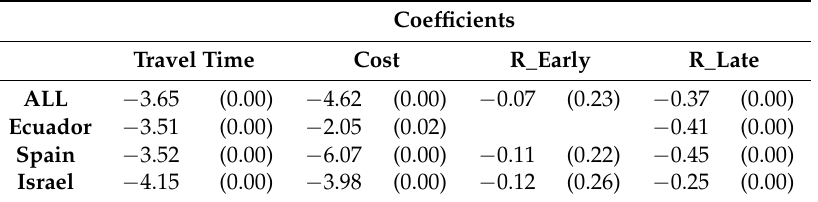
Table 3. Results from the final logit models ( p values in parenthesis).